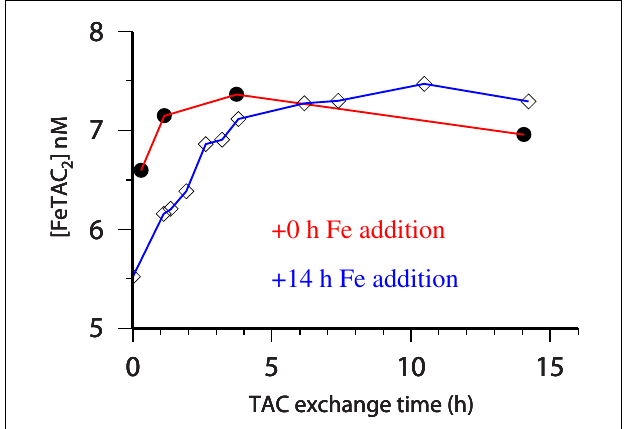
FIGURE 2 | CSV-KIN: time course of recovery of Fe byTAC from natural iron binding ligands. Water sample is from 60m at Station 28 (see Table 1 for more details) during the Meteor 55 cruise. Black circlesTAC added immediately after Fe addition, open diamonds,TAC added 14h after iron addition.